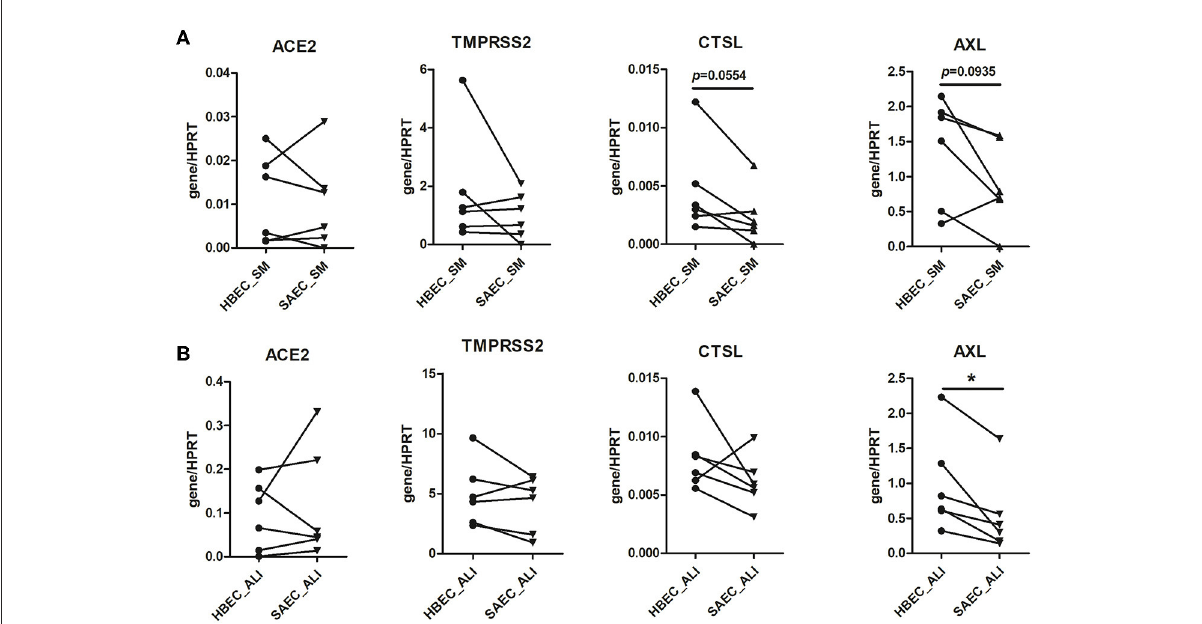
FIGURE1 Comparison of expression of SARS-CoV-2 entry genes between human bronchial epithelial cells (HBEC) and small airway epithelial cells (SAEC). HBEC and SAEC derived from the same donors were submerged cultured (SM) (A) or differentiated under air-liquid interface (ALI) conditions (4 patients, 6 cultures) (B) . Gene expression of SARS-CoV-2 entry genes including ACE2, TMPRSS2, CTSL and AXL was determined by LightCycler PCR and normalized to HRPT expression. Comparisons on expression of the four SARS-CoV-2 genes between HBEC and SAEC from same donors are performed for cells cultured in submerged culture and ALI culture. Statistical significance was determined by paired t test ( n = 6). * p < 0.05.